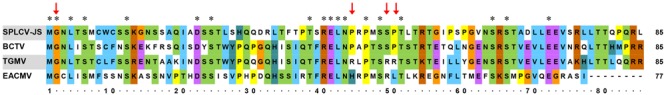
Comparison of amino acid sequences of SPLCV-JS C4 proteins with those of other geminiviruses. Conserved amino acid residues among these sequences are indicated by the asterisks and key amino acid residues related to geminivirus C4 function by red arrows. BCTV, Beet curly top virus; TGMV, Tomato golden mosaic virus; and EACMCV, East African cassava mosaic Cameroon virus.